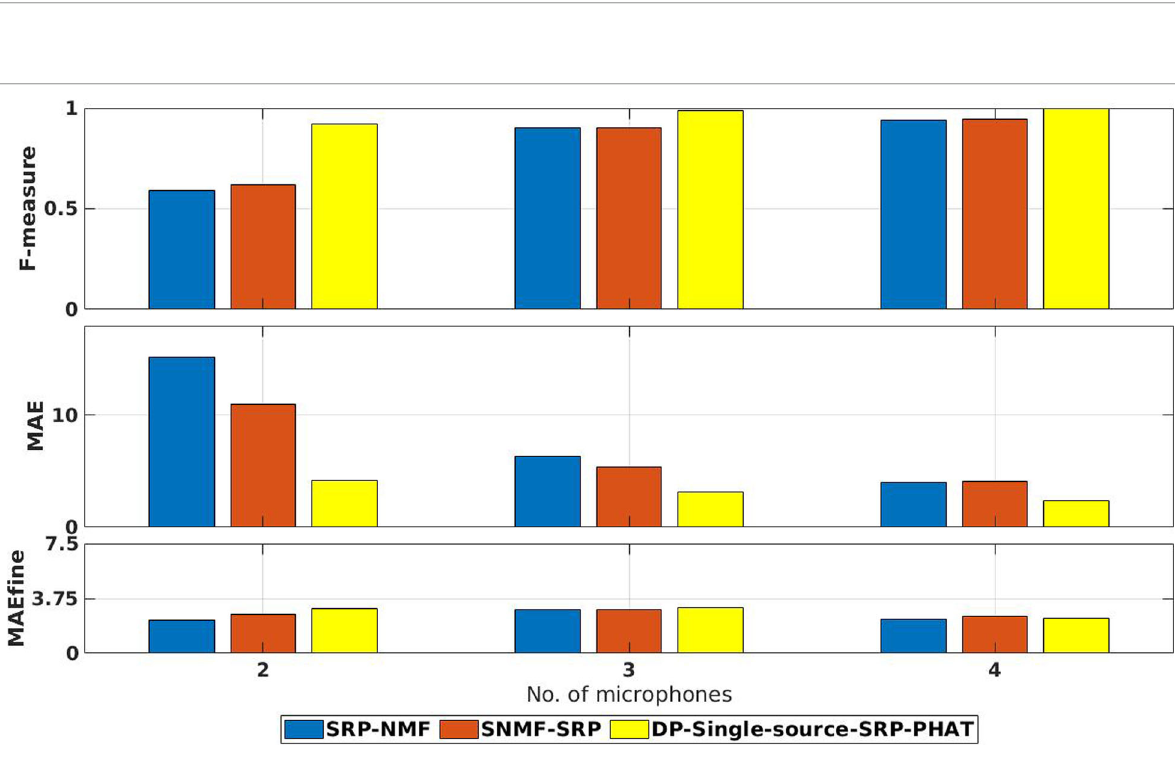
Fig. 8 Performance comparison of SNMF-SRP, DP-single-source-SRP-PHAT, and the proposed SRP-NMF in terms of the chosen instrumental metrics on the AACHEN dataset. The results are depicted for subsets of a uniform linear array with an inter-microphone spacing of